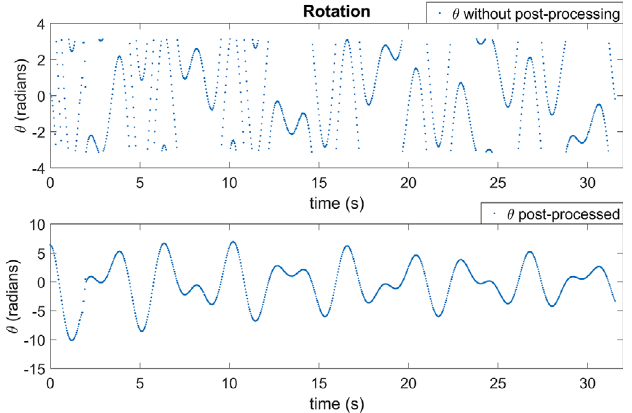
Fig. 5. Comparison between the geometrical angle in [ (cid:1) p , + p ] and the post processed angle, corresponding to our fi nal values of u versus time.